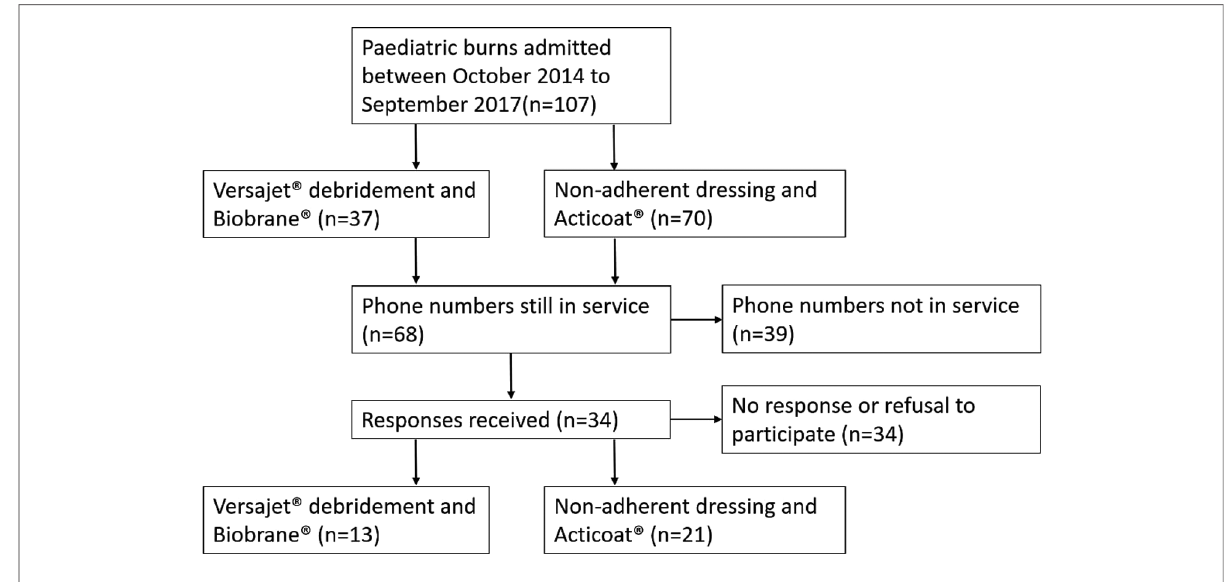
FIGURE 1 Flowchart of patient